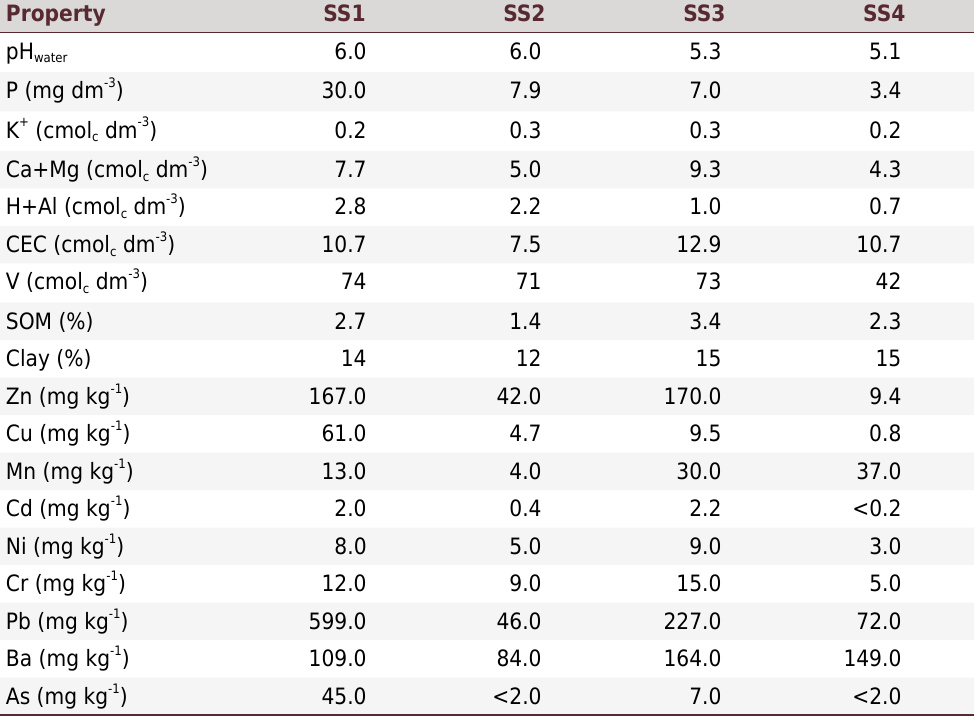
Table 1. Chemical and physical properties of the soil samples from a multi-metal-contaminated site used in this study Property SS1 SS2 SS3 pH water